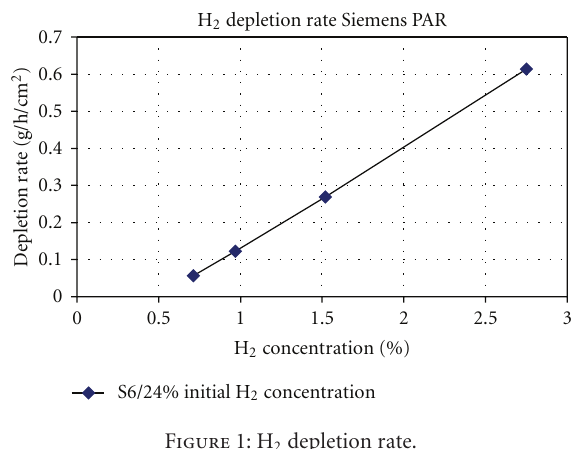
Figure 1: H 2 depletion